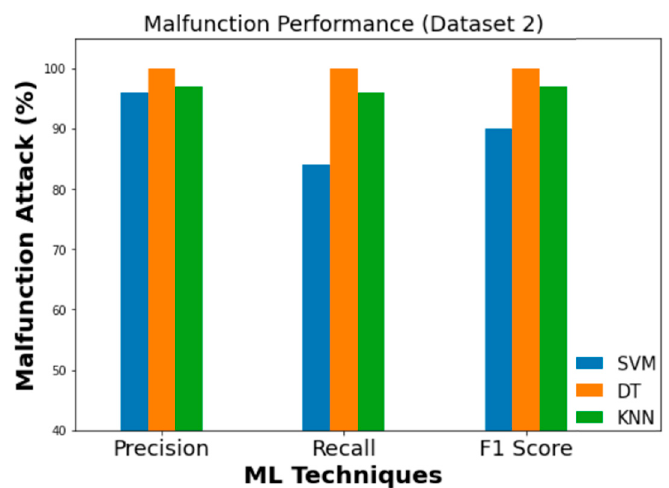
Figure 21. Performance evaluation metrics (malfunction).